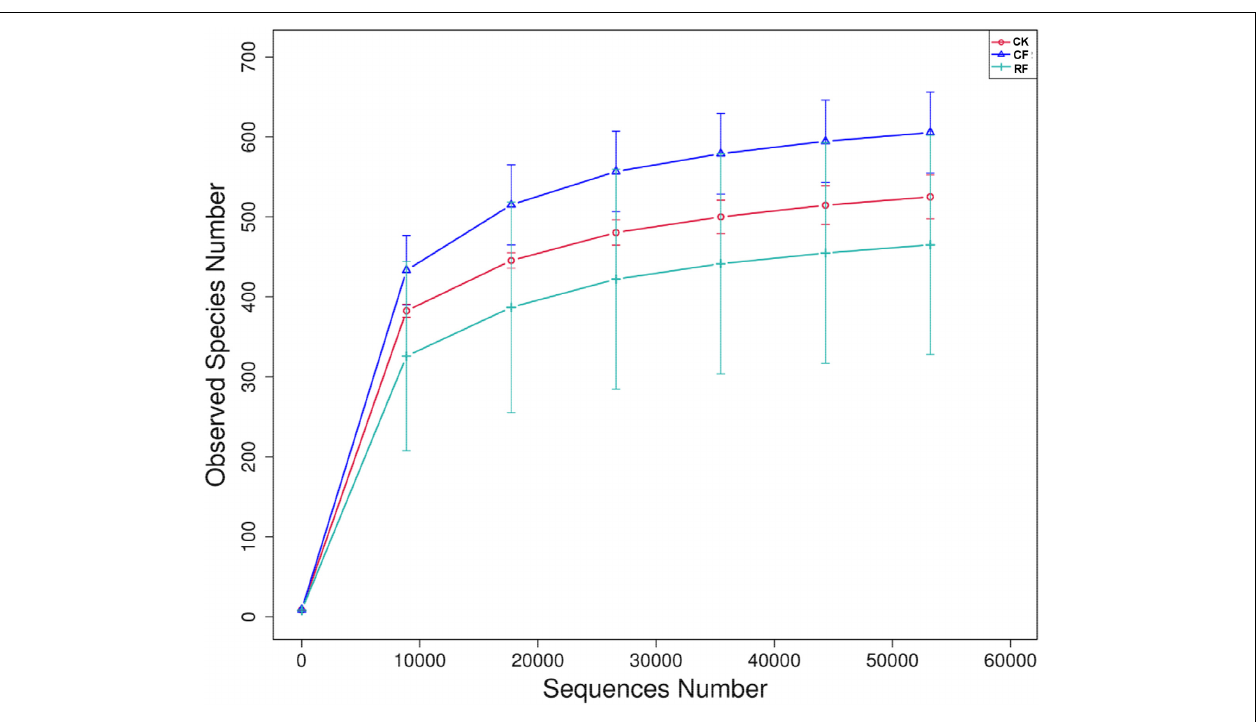
FIGURE 1 | Rarefaction curves for all of the soil samples. CK, CF, and RF indicate without fertilizer applied, with compound fertilizer applied, and reduced fertilizer applied,